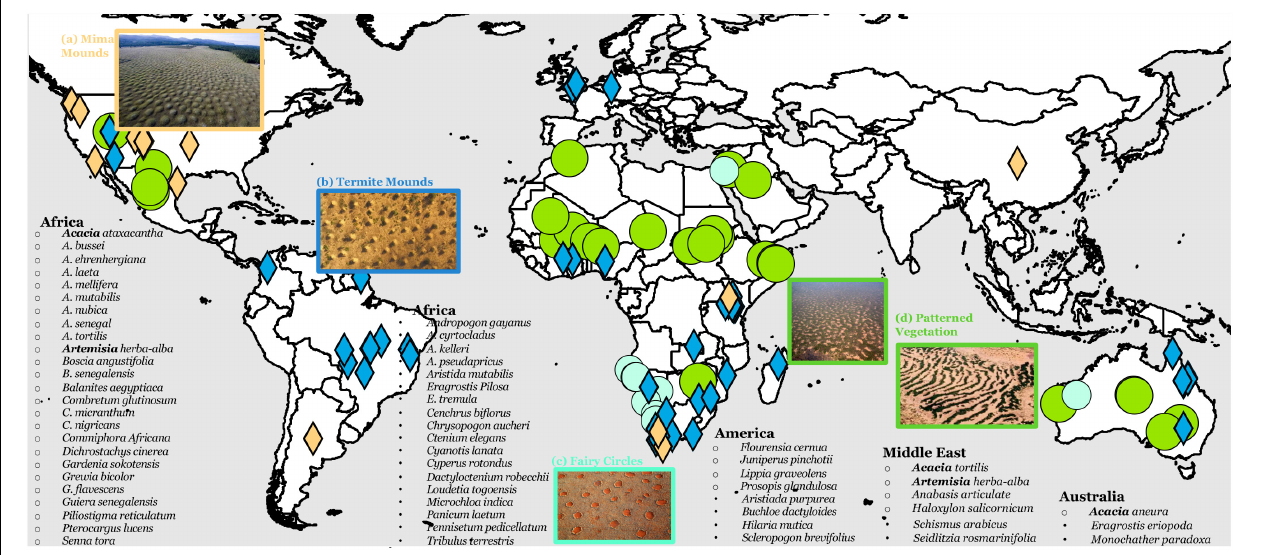
FIGURE 2 | Distribution of self-organized, regular ecological patterns— (A) mima mounds, (B) termite mounds, (C) fairy circles, and (D) patterned vegetation around the world and pattern-forming species associated with patterned vegetation on each continent. Open bullet point indicates dominant woody species and solid bullet points are dominant herbaceous species in the patterns. Generic names that appear on more than one continent are in